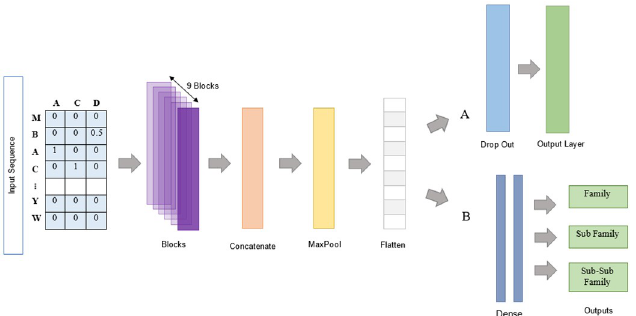
Fig 2. The architecture of the proposed feedforward DeepHiFam model. Encoded sequences are fed into the feature extraction blocks. Extracted feature maps are concatenated before the 1D max pool layer which reduces the dimensionality. After the flattening layers, two different classification sections are separately designed as shown in parts A and B for non-hierarchical and hierarchical multi-class classification respectively. The classification section-A has a fully connected (Dense) layer with softmax activation function. Section-B has multi-outputs which include fully connected layers that are connected to the final fully connected layers. Dropout layers are also used with a 0.5 rate after the flattening layer and the fully connected layers to avoid the overfitting of the model.